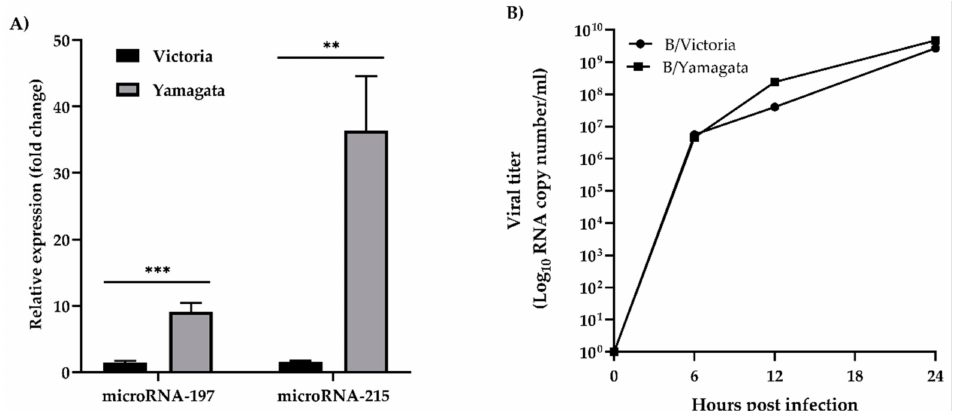
Figure 2. ( A ) Validation of cfa-miR-197 and cfa-miR-215 at 24 hpi by RT-qPCR. Although both cfa-miR-197 and cfa-miR-215 were upregulated upon influenza B virus infection, the expressions of both microRNAs found in the MDCK cells infected with Yamagata lineage were significantly higher than those found in Victoria lineage infection ( p ≤ 0.01 is designated as **; p ≤ 0.001 is designated as